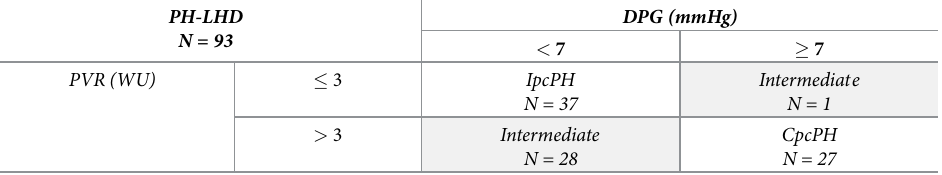
> 3 CpcPH N = 27 CpcPH = combined post- and pre-capillary pulmonary hypertension; DPG = diastolic pressure gradient; IpcPH = isolated post-capillary pulmonary hypertension; PH-LHD = pulmonary hypertension due to left heart disease; PVR = pulmonary vascular